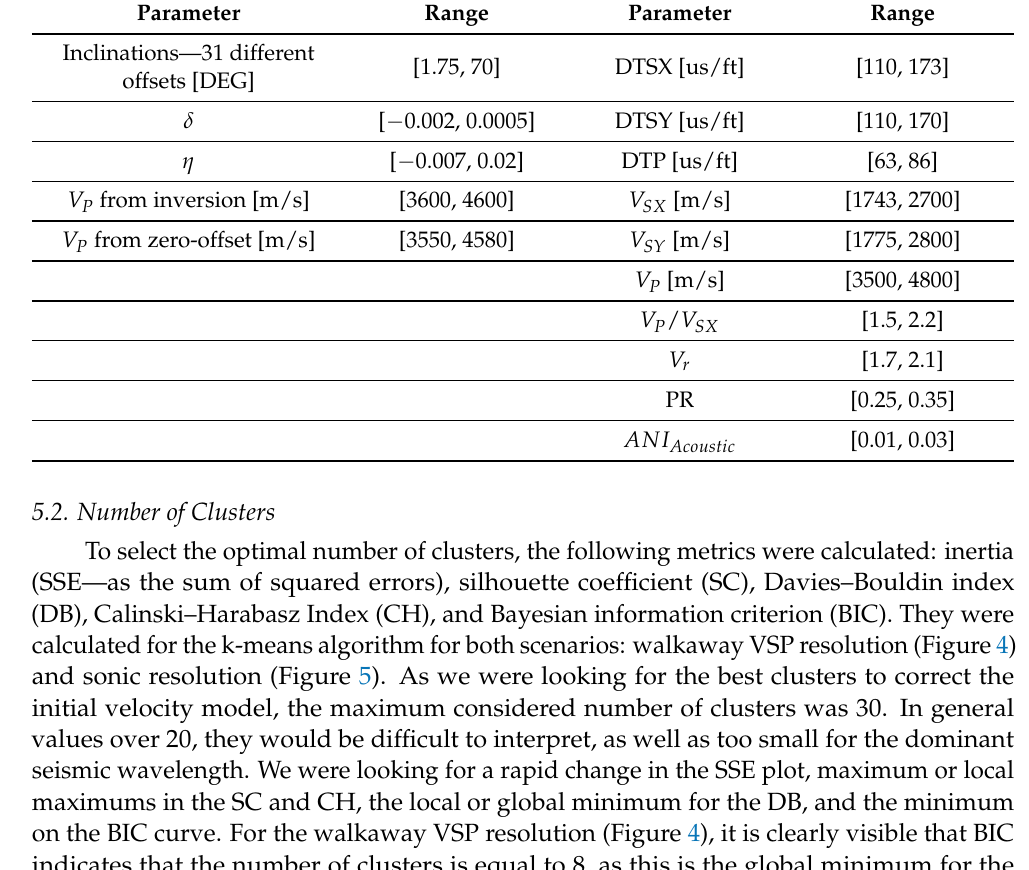
Table 2. Input parameters used for clustering with their measurement range Walkaway VSP Data